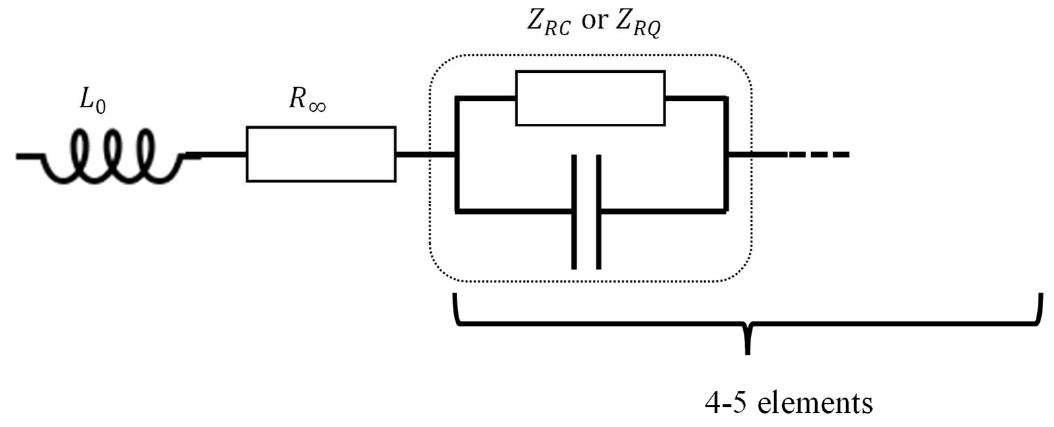
Figure 4. Chart of the equivalent circuit model.